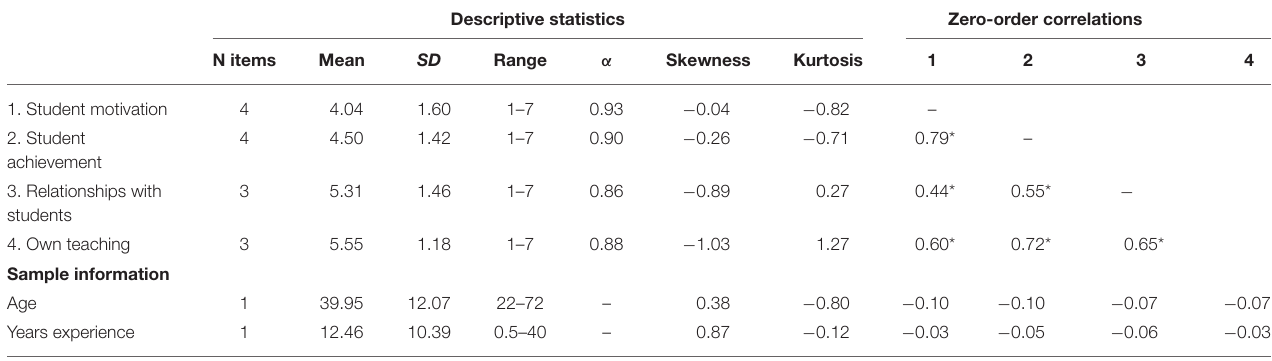
TABLE 1 | Descriptive statistics and correlations for the teacher responsibility scale in the quantitative strand ( n = 180).